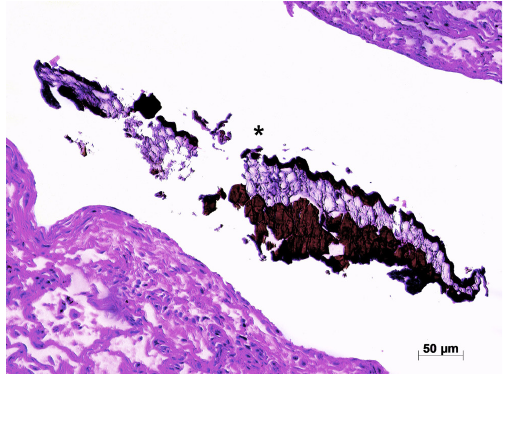
Figure 10. Lung of the dog which died due to heartworm infection showing a recanalized thrombus showing a worm fragment.